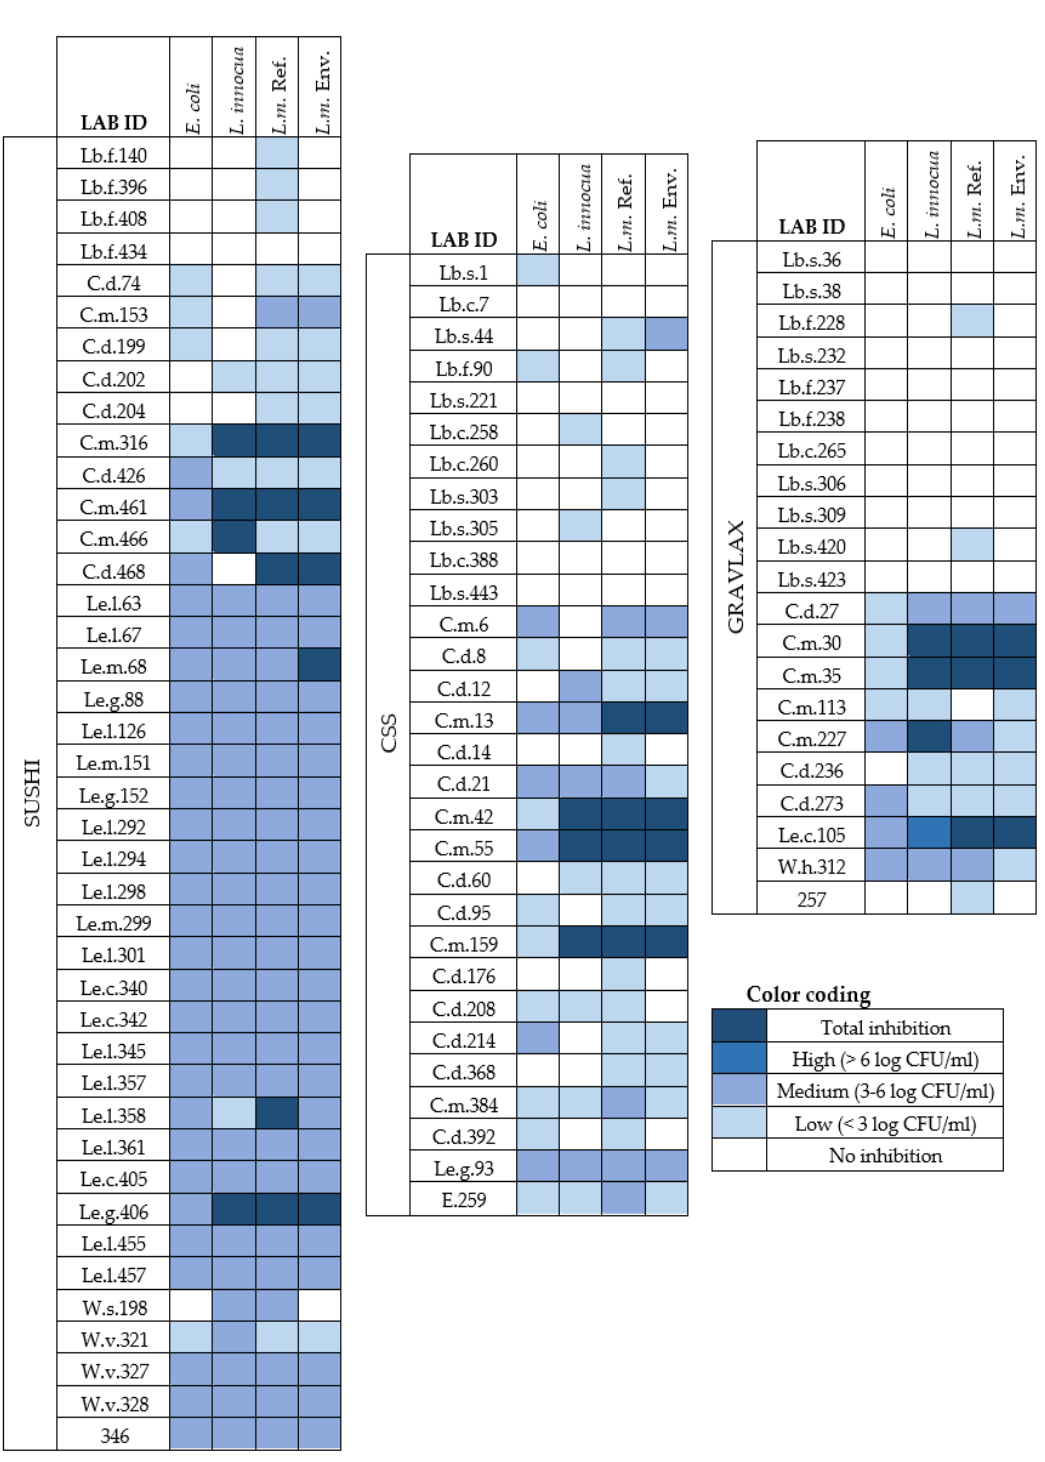
Figure 3. Growth inhibitory effect of LAB isolated from sushi ( n = 41), CSS ( n = 30), and gravlax ( n = 21) against L. innocua , the L. monocytogenes (L.m.) reference strain, the L. monocytogenes environmental strain, and E. coli. Inhibition levels are given in color codes, as shown, based on ∆ log CFU/mL, i.e., the difference between the average concentration (log CFU/mL) of the target monoculture ( n = 8) and the concentration (log CFU/mL) of the target obtained in coculture with LAB ( n = 4). C.d.: Carnobacterium divergens; C.m.: C. maltaromaticum; Lb.s.: Lactobacillus sakei; Lb.f.: Lb. fuchuensis; Lb.c.: Lb. curvatus; Le.c.: Leuconostoc citreum; Le.g.: L. gelidum; Le.l.: L. lactis; Le.m.: L. mesenteroides; W.h.: Weissella hellenica; W.s.: W. soli; W.v.: W. viridenscens; E.p.: Enterococcus pseudoavium. Strains with only a number were not